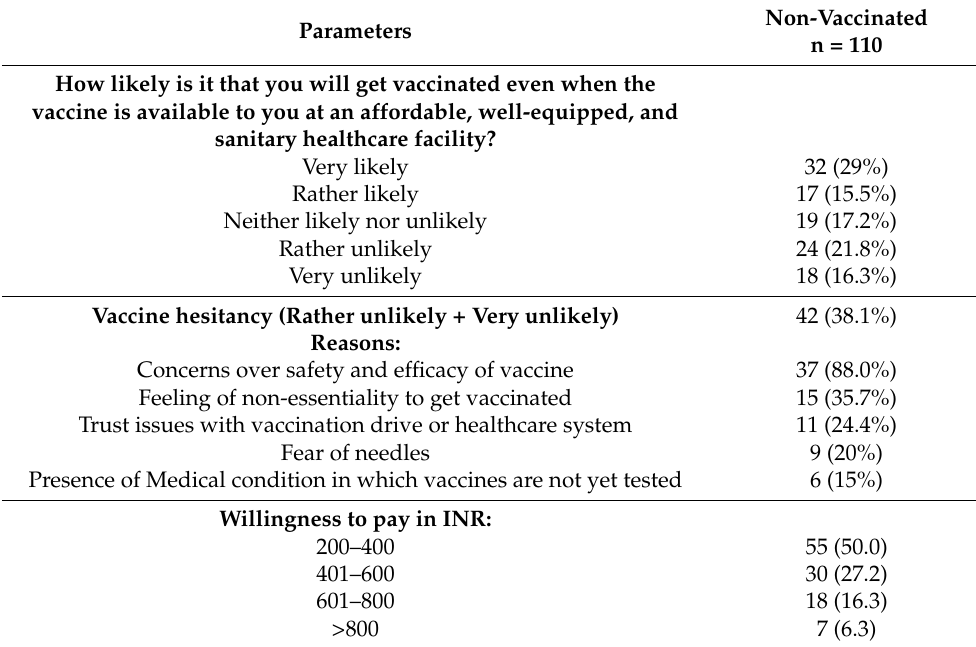
Table 4. Vaccine hesitancy among non-vaccinated